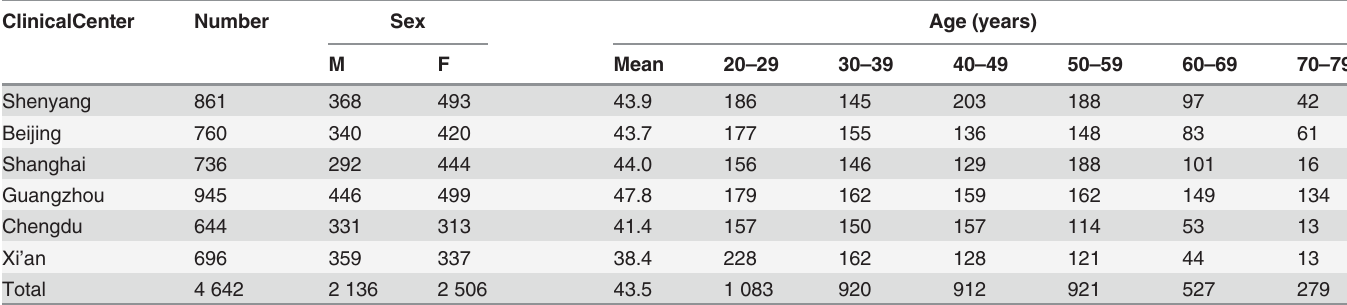
Table 1. Population Demographics for Establishing the Reference Range by Center.